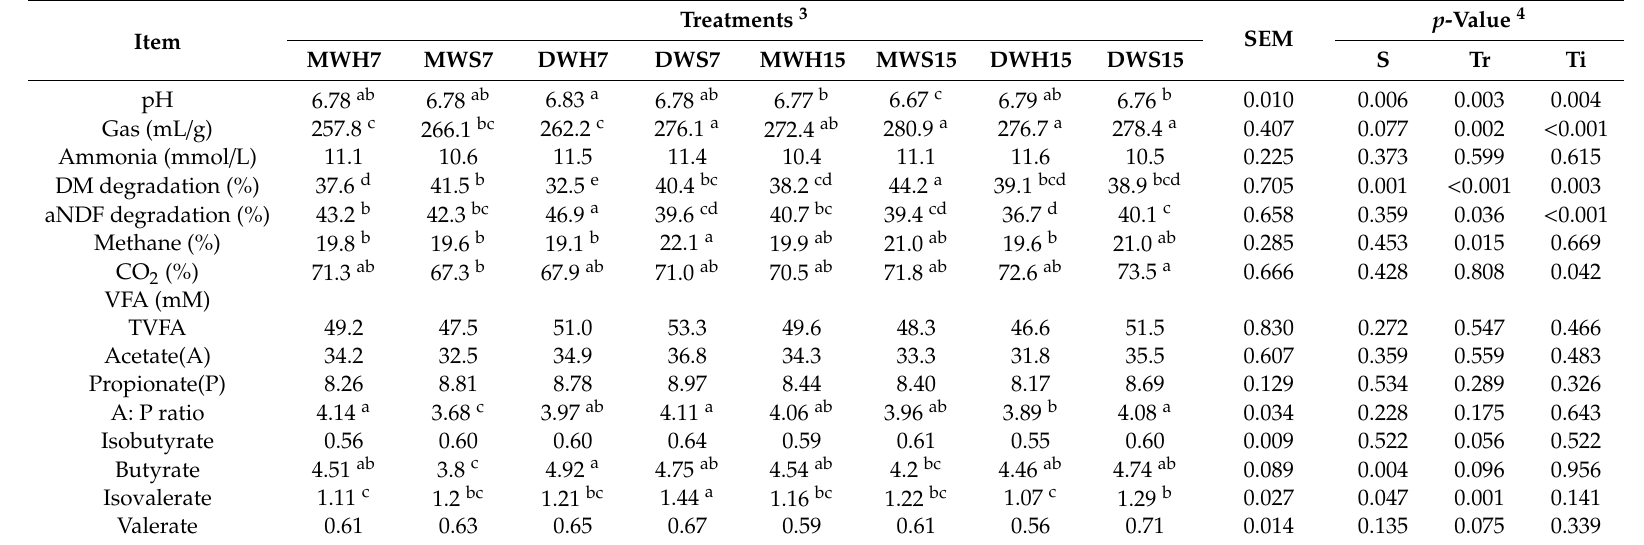
Table 2. E ff ects of di ff erent treatments on vitro fermentation 1,2